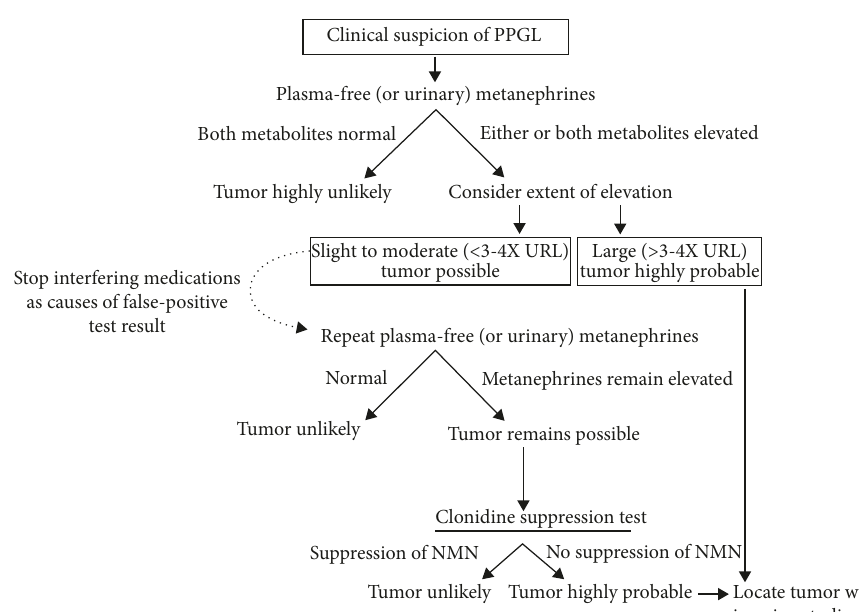
Figure 8: Flow chart illustrating the indications for the biochemical screening algorithm in a clinically suspected paraganglioma. NMN: normetanephrine. Citation: European Journal of Endocrinology 170, 3; Table 1: Parameters and score in the Grading system for Adrenal